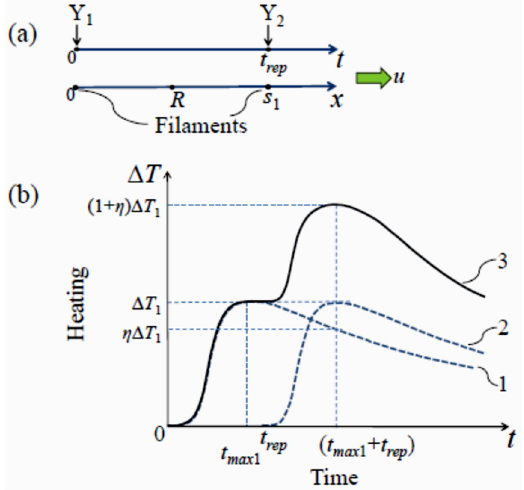
Figure 5. Schematic of heating of the space between two neighbour filaments due to the propagation of energy in the material by the thermal diffusion. The condition r f << R is met for the filament radius r f . ( a ) The point r = R = 0.5 s 1 (in the plane π of the cross-section of a set of filaments shown in Figure 4a) is placed in the middle between two neighbour filaments separated one from another by the step s 1 of filaments following. ( b ) 1 is the heating curve for the point r = R by the filament created by the pulse Y 1 coming to the point x = 0 at the time t = 0. ∆ T 1 is the maximum of this curve reached at the time t = t max 1 . 2 is the similar heating curve for the same point r = R , but by the filament created by the next pulse Y 2 coming to the point x = s 1 at a distance s 1 of the step of filaments following from the previous point x = 0 and with a delay t rep relative to the pulse Y 1 . The same maximum ∆ T 1 of this curve is reached at t = t max 1 + t rep . At this time, the heating by the first filament decreases due to cooling down to η ∆ T 1 , where η (<1) is a coefficient of heat preservation. 3 is the curve of the resulting heating of the point r = R by both these neighbour filaments. Its maximum ≈ (1 + η ) ∆ T 1 is reached at the time ≈ ( t max 1 + t rep